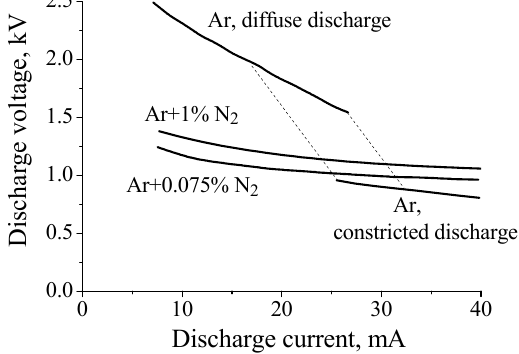
Figure 2. Current–voltage characteristic of discharges in pure argon and the Ar/N 2 mixtures at gas pressure P = 40 Torr [15,34].